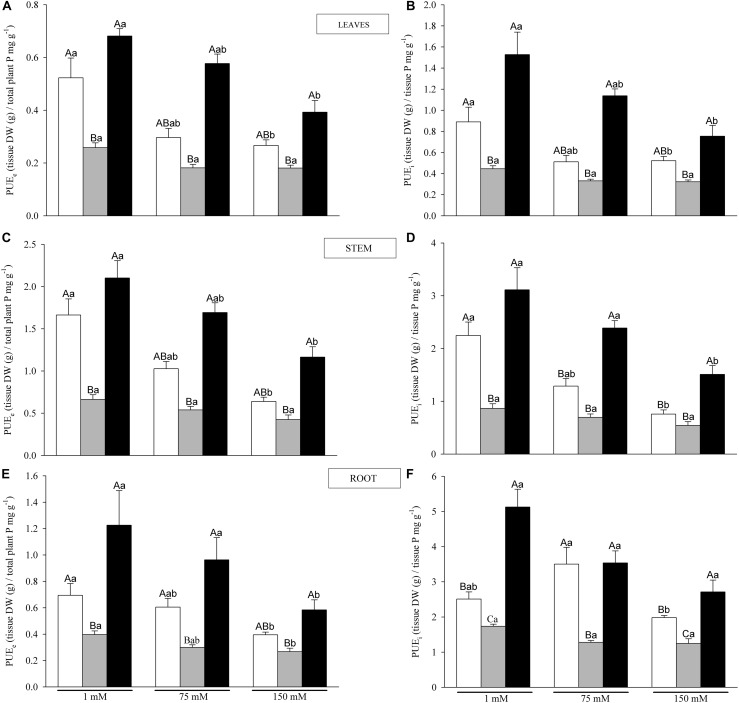
Phosphorus use efficiency external and internal (PUEe and PUEi, respectively), of leaves (A,B), shoots (C,D) and roots (E,F), for C, P and AM plants (white, gray and black bars, respectively) under 1, 75 and 150 mM NaCl. Values are mean and standard error of at least four replicates per treatment. Different capital letters indicate significant differences among nutritional levels (C, P and AM) within the same salt level, and lowercase letters indicate significant differences among salt levels within the same nutritional level, from post hoc Tukey test.